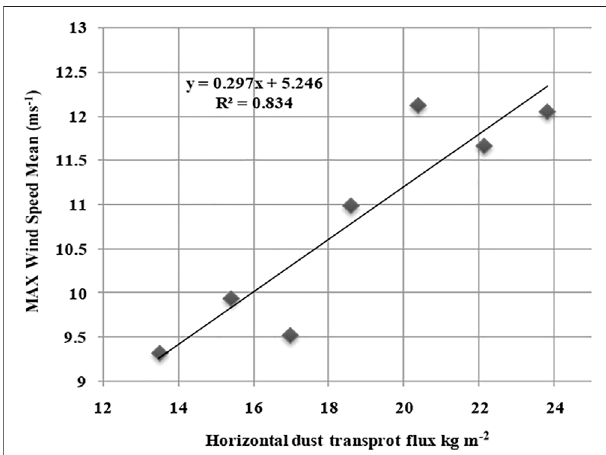
FIGURE 8 | Scatter diagram of the average maximum wind speed across the seven levels versus the horizontal dust transport fl ux (kg m − 2 ) (Huo et al., 2016) Figure 8 cites the results of 2016, from the 10 dust storm processes in TZ, with both Q and maximum wind speed taken as an average of the 7-level observed heights of the 10 dust storm processes. The windspeedsduringthefourdustprocessesareusedforcomparativeanalysis in Figure9 .Thesefourprocessesaresystemicweather-inducedduststorms, and the dust storms occur at the same time period at XT station and TZ station, so they are more representative.